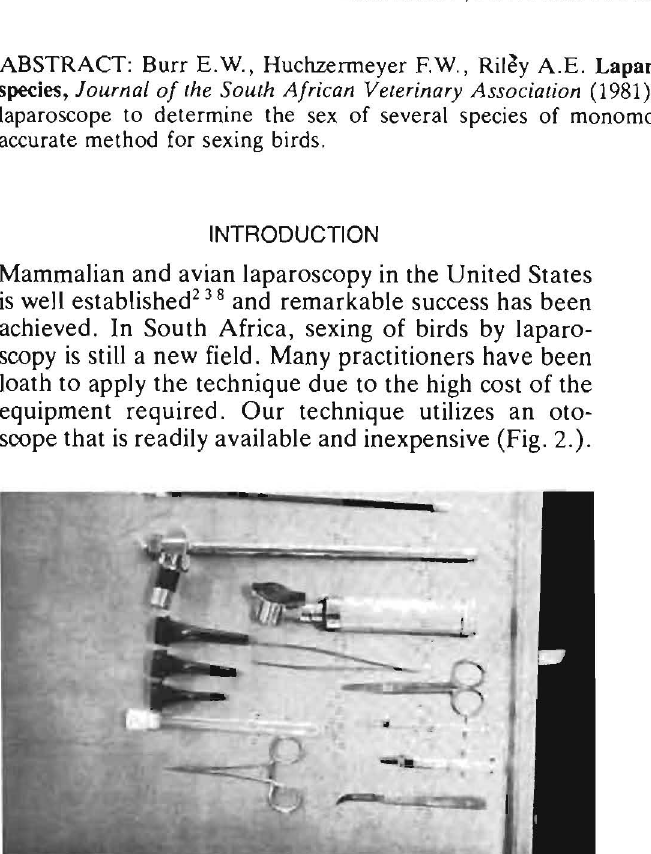
Fig. 2 Instrumentation required to perform laparoscopy in birds.